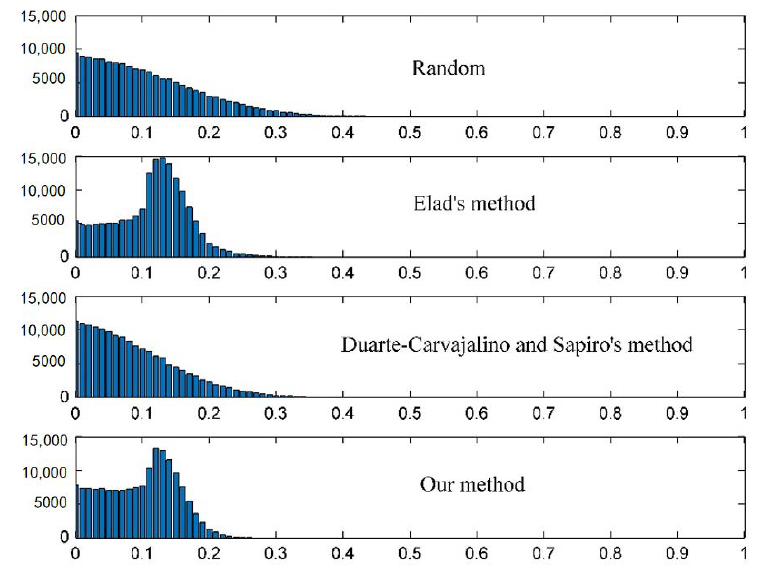
Figure 2. Histogram of the absolute off-diagonal entries of the corresponding normalized Gram matrix to each of the four sensing matrices.